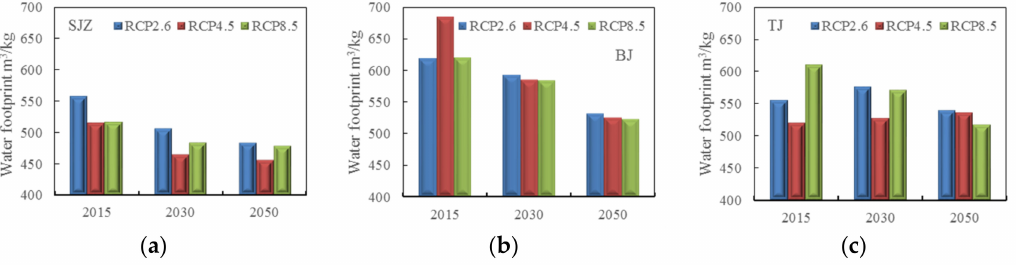
Figure 8. The water footprint of wheat in the different RCP scenarios. ( a – c ) are water footprint for Shijiazhuang, Beijing, and Tianjin, respectively.